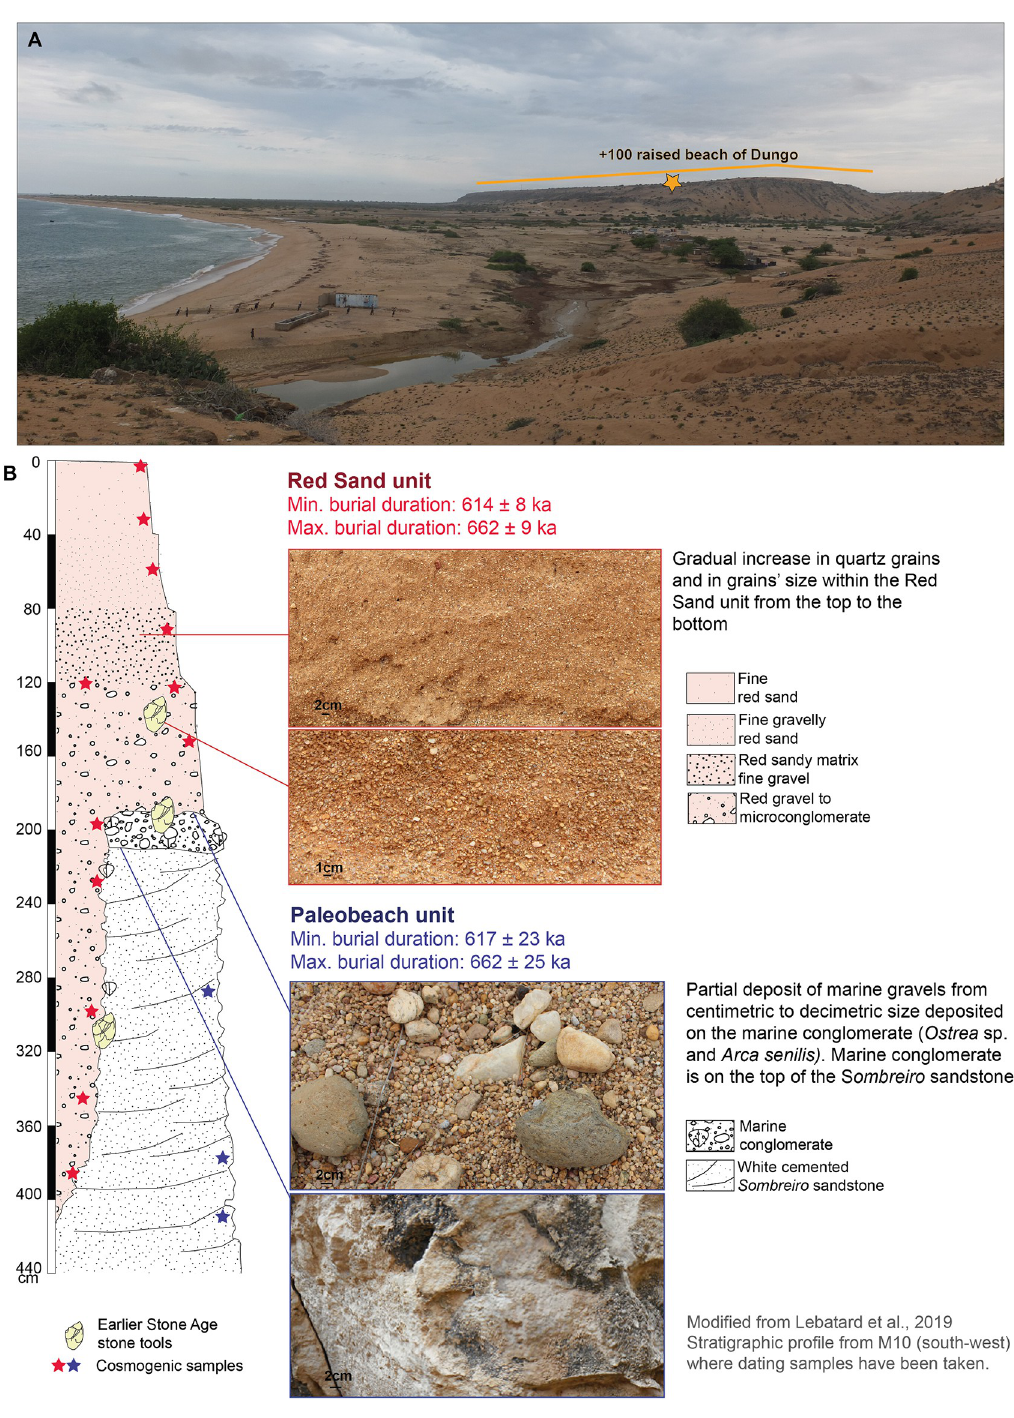
Fig 3. A: Stratigraphy of Dungo IV from 2018–2022 fieldwork; B: overview of the geological features of the +100m raised beach at Dungo IV; C: a layer of quartz artifacts on the top of the layer « red gravel to microconglomerate » of the Red Sand unit, identified in 2022 within the profile of a test-pit from